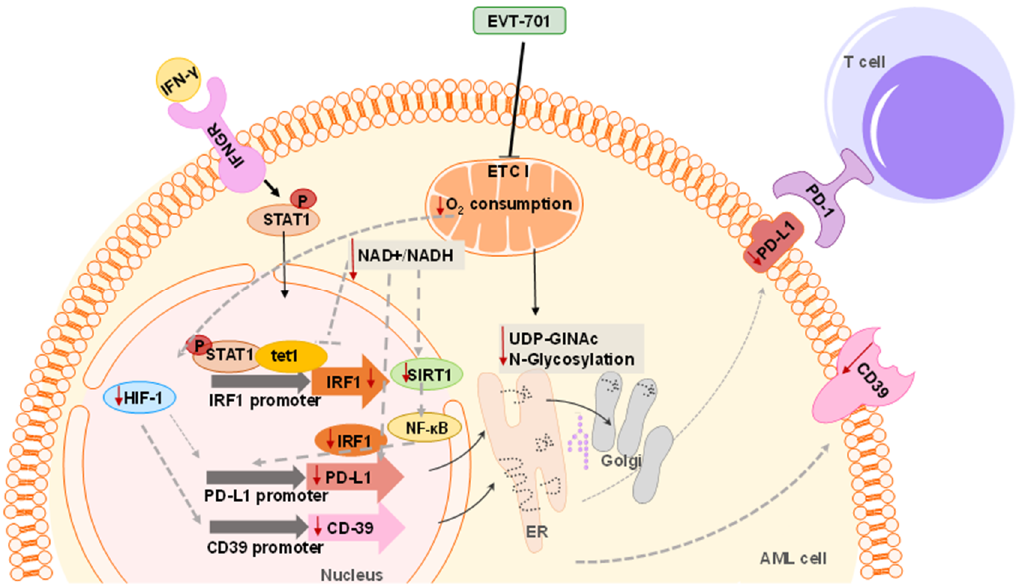
Figure 5. Schematic view of the proposed mechanism of action of EVT-701 as modulator of the immune checkpoints PD-L1 and CD39 membrane levels.